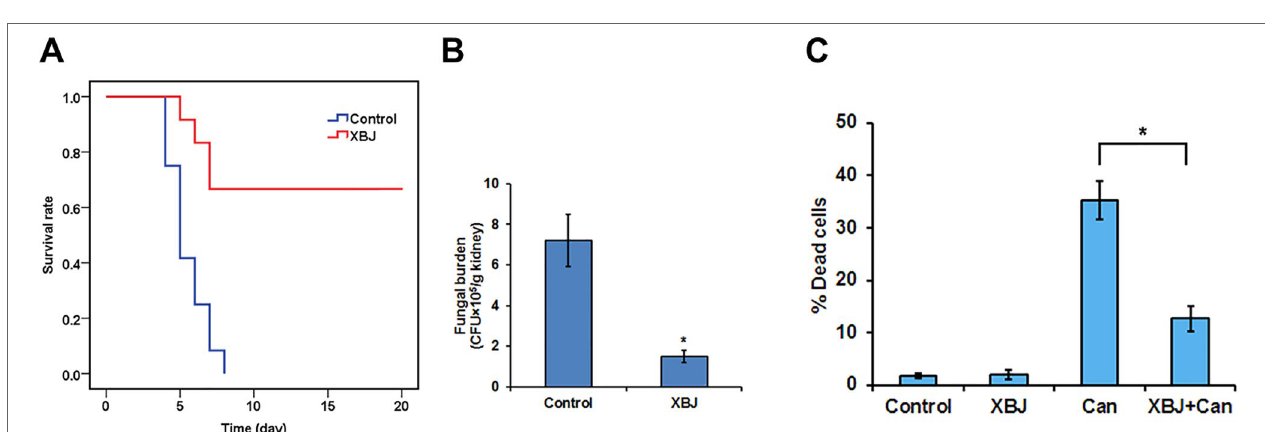
FIGURE 5 | XBJ pre-treatment inhibits the colonization of C. albicans in the kidney. (a) The survival curves of XBJ pre-treated and control mice after systemic C. albicans infection. XBJ (6 ml/kg) or 0.9% NaCl was administered by abdominal injections once/day for 3 days before systemic C. albicans infection to the treatment group or the control group. (B) The colony-forming assay to determine the fungal loads in the kidneys of control and XBJ treated mice. Kidney tissues from control and XBJ treated kidneys were harvested and subjected to C. albicans culture 4 days after the infection. Colonies were counted after 48 h of culture. (C) PI staining was used to determine the effect of XBJ on the survival of 293T cells 8 h after the C. albicans infection. *P <